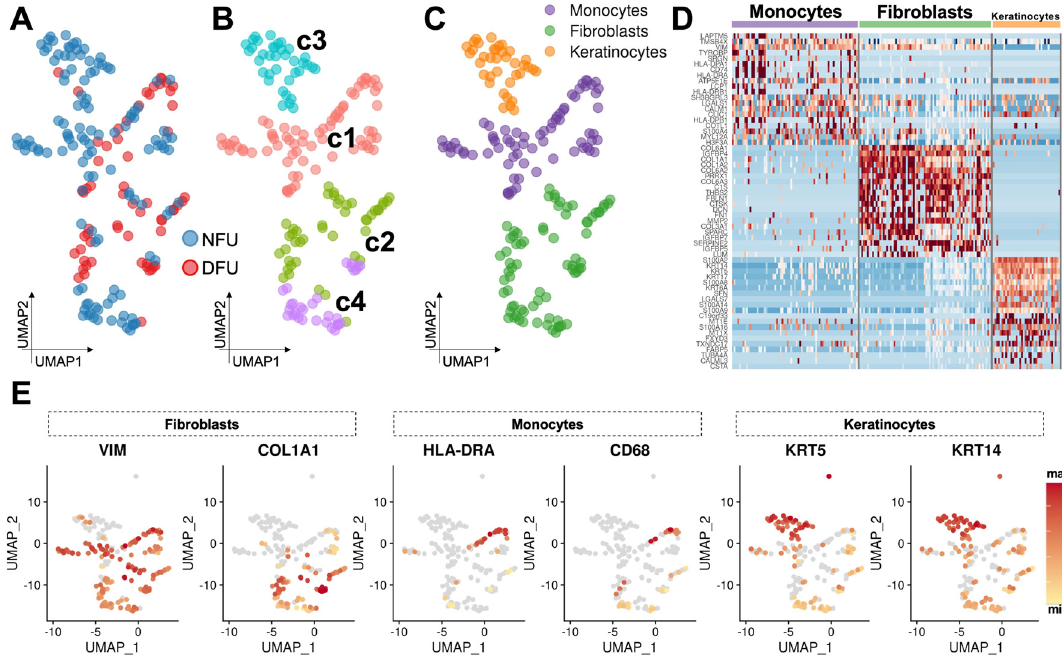
Figure 3. Re-clustering of initial fibroblast clusters demonstrate four provisional subclusters. ( A , B ) Recursive re-clustering reveals four provisional subclusters ( c1–c4 ) which further identify as ( C ) fibroblasts, monocytes, or keratinocytes. ( D ) Heatmap demonstrating top differential genes between these newly refined cell annotations. ( E ) Manual evaluation of key cell type markers.